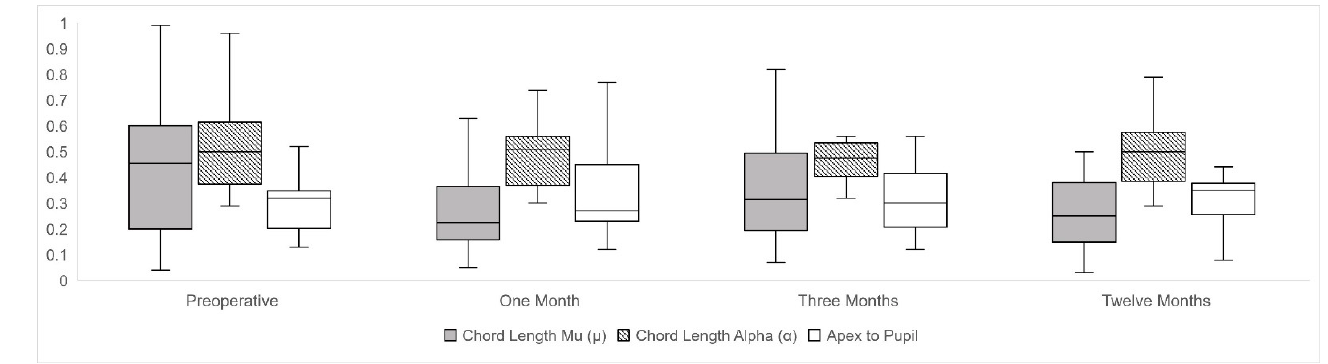
Figure 2. Longitudinal changes of chord length mu (µ), chord length alpha ( α ) and apex to pupil distance (APD) along preoperative and postoperative follow-up represented by box and plot graphs, expressed in millimeters (mm).